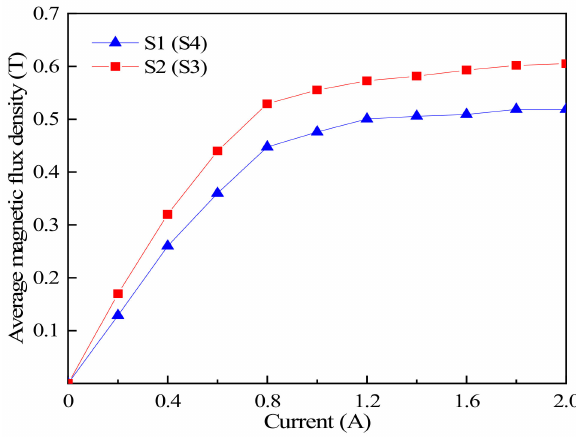
Figure 9. Variation of average magnetic flux density with current.